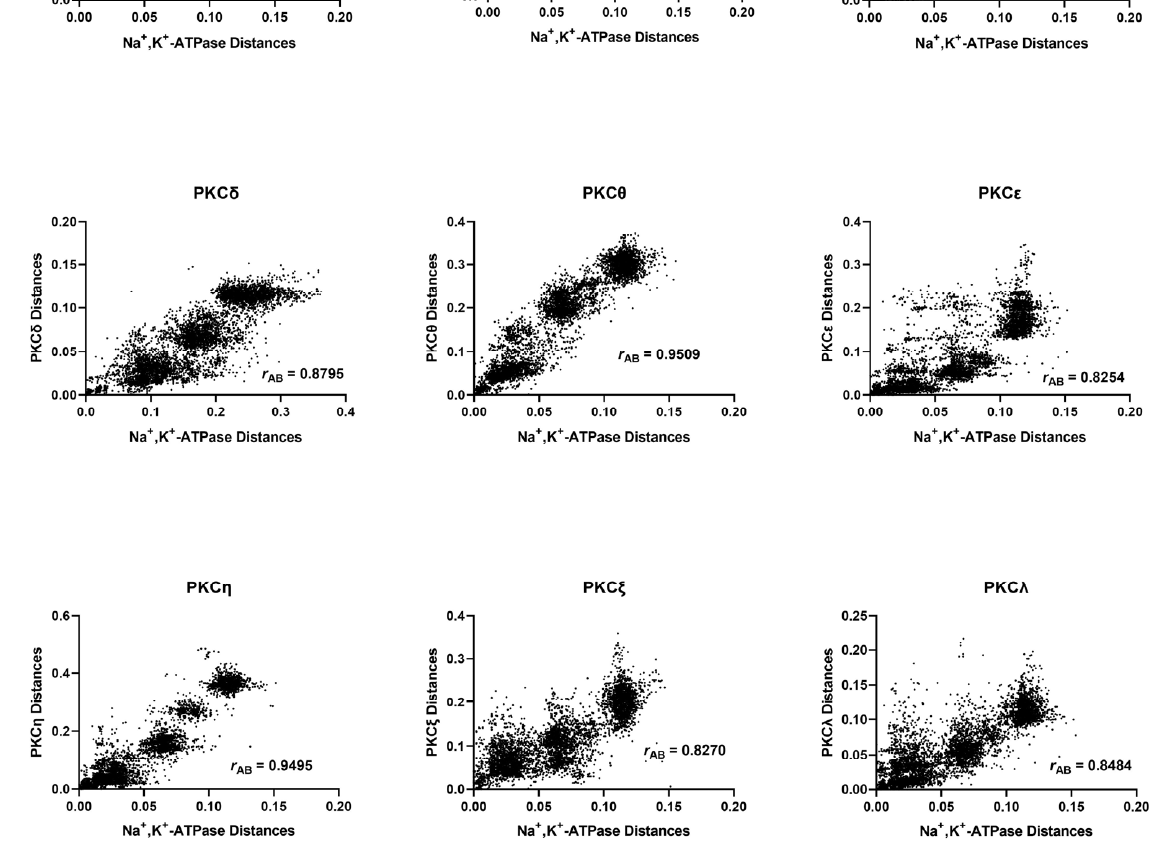
Figure 2. Correlations of evolutionary distances between common organisms expressing various isoforms of PKC and the Na + , K + -ATPase α 1 -subunit. Each data point represents a combination of a pair of common organisms for each protein as explained in the Methods section. Hence, there are many more data points than common organisms. For comparison, the top row of the figure shows correlations of the positive control, PI3K-I A , with the Na + , K + -ATPase followed by two negative controls, i.e., PKC α , with EGFR followed by hexokinase with the Na + , K +